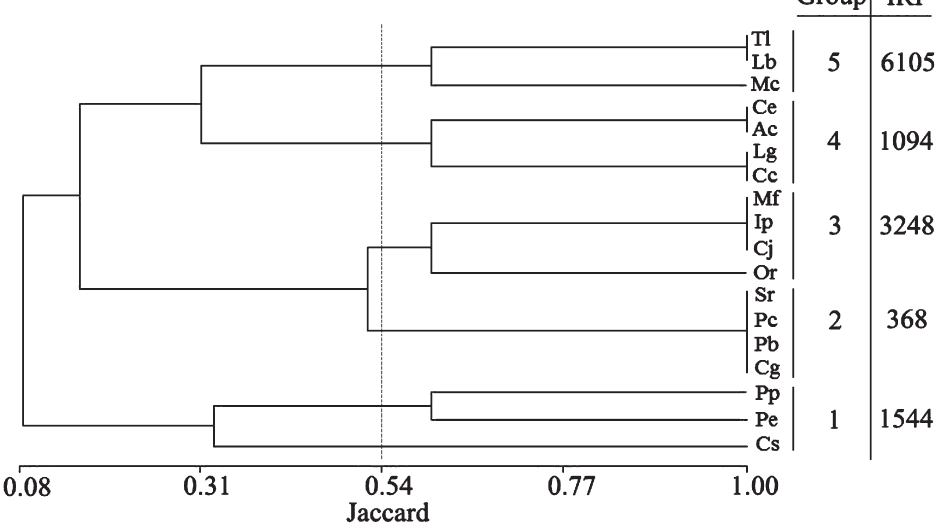
Fig . 2. – Dendrogram of prey species of the Guiana dolphin in Norte Bay in relation to behavior descriptors. Samples were clustered using the Jaccard index. The cophenetic correlation was 0.903. Abbreviations: Index of Relative Importance (IRI). Prey codes in Table 1. Each group is described in the